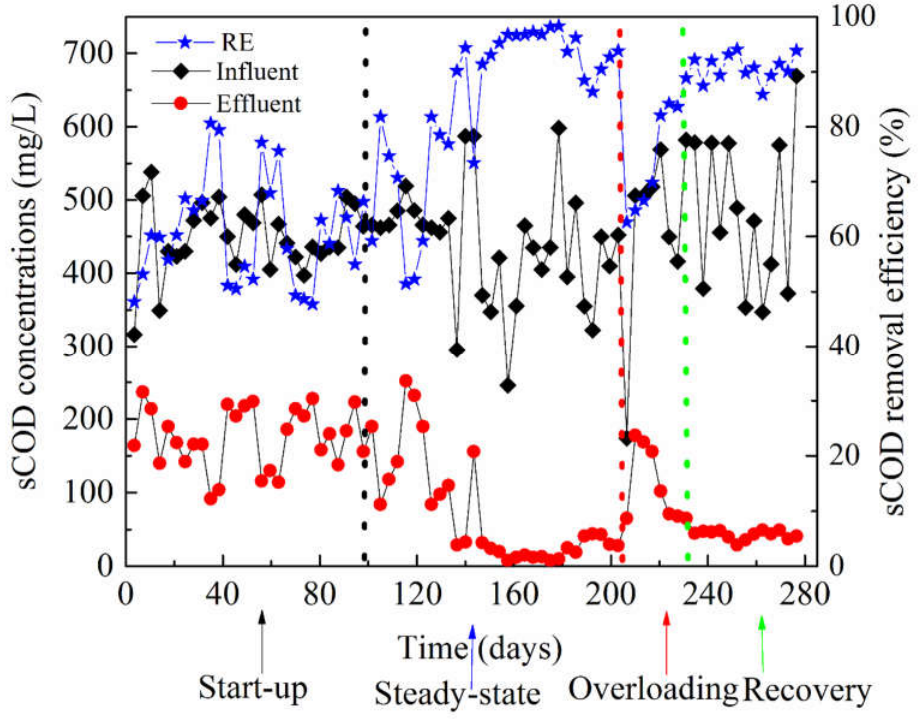
Figure 5. COD removals in the AnMBR process.